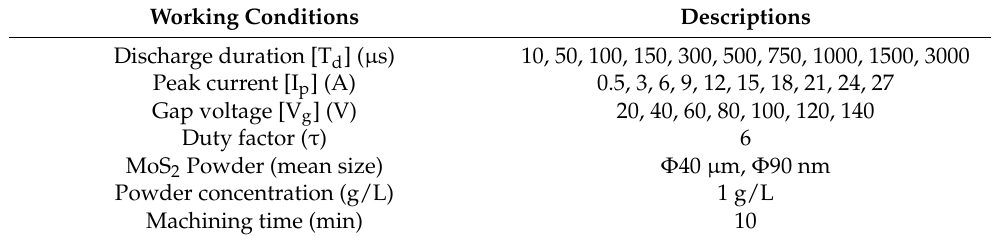
Figure 3. Experimental setup for PMEDM process. Table 2. Experimental